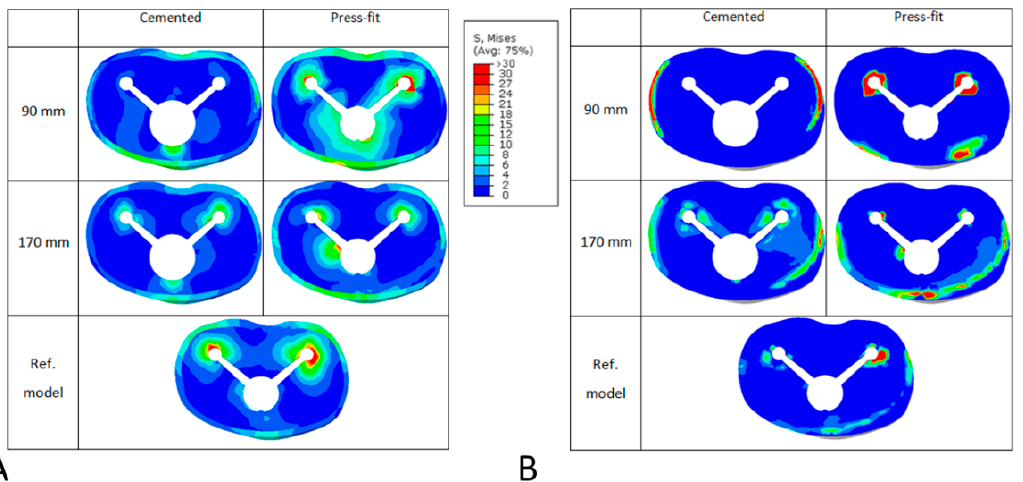
Figure 6. Graphical overview of the von Mises stress ( A ) and of the contact pressure ( B ) at the tibial-bone interface for cemented and press-fit configurations, for stems of 90 mm or 170 mm in length, compared with the reference model in which no stem is present.